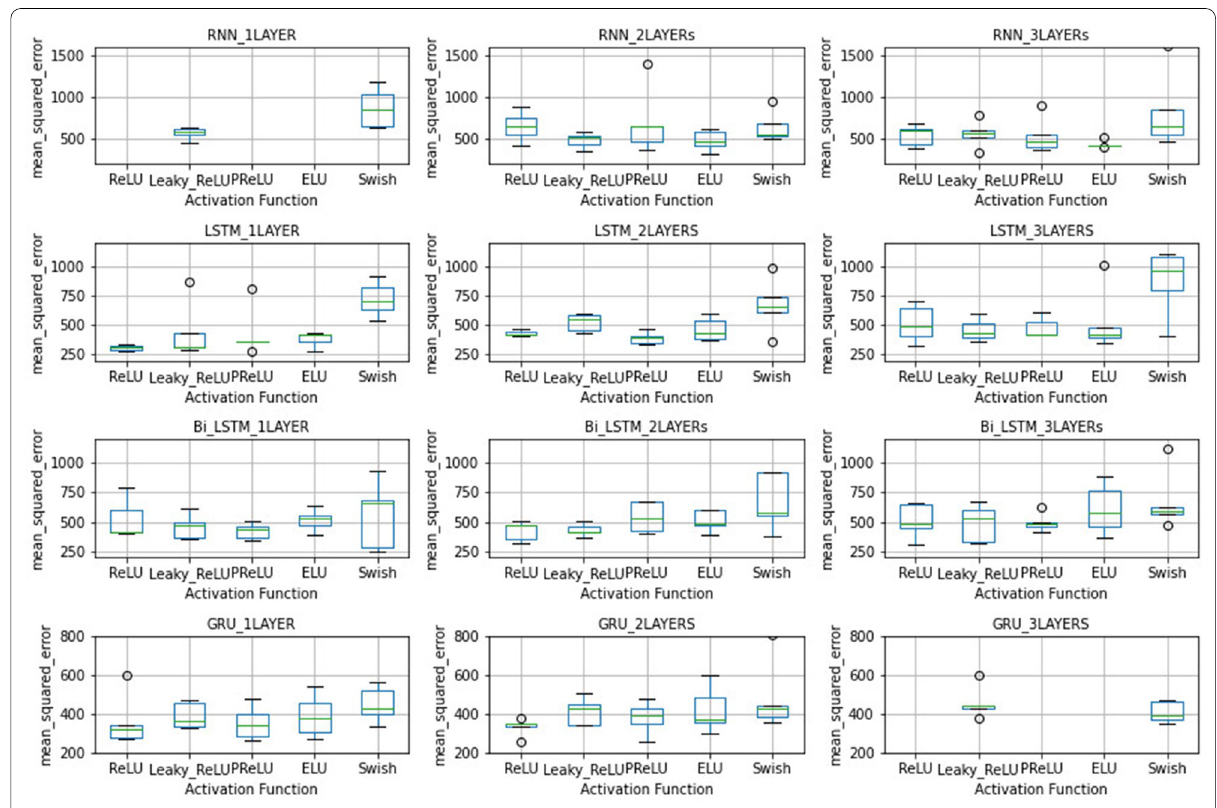
Figure 7 Performance of different activation functions on the test